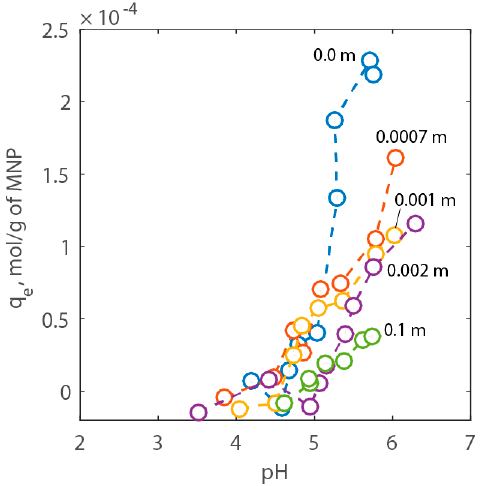
Figure 7. Adsorption results expressed as adsorption capacity of Ca 2+ vs. pH for NaCl concentration between 0.0 to 1 wt % corresponding to 0.0 to 0.1 m, respectively.